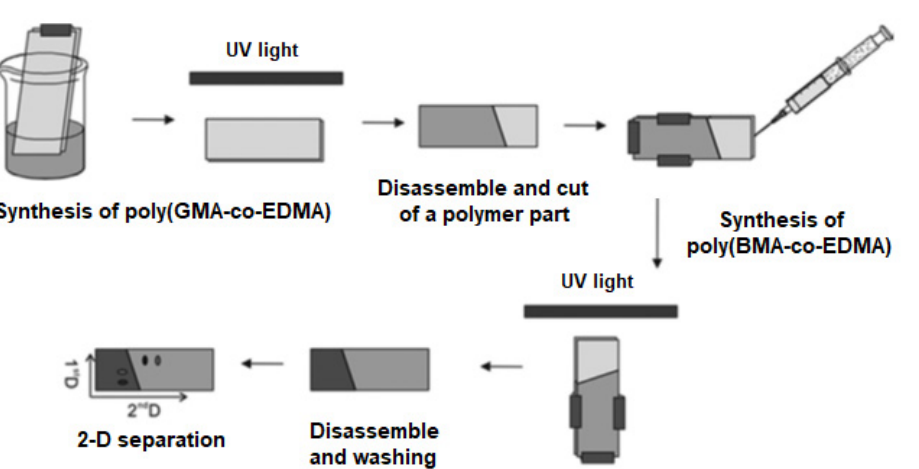
Figure 3. Scheme of preparation of the macroporous monolithic layer for 2-D TLC. Reprinted at modified form from [51] with permission of John Wiley and Sons.